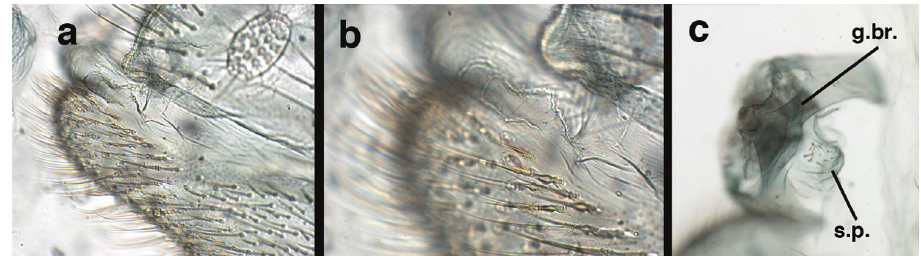
Figure 42. Ungla favrei (Navás): Male terminalia, ( a, b ) tip of segment A9, lateral, showing patch of enlarged, flanged setae on lateral margin of S9 and large, but unmodified setae on tip of S9 ( c ) subanal plate above gonarcal bridge. g.br. gonarcal bridge s.p. setose subanal plate (Bolivia, Cochabamba,